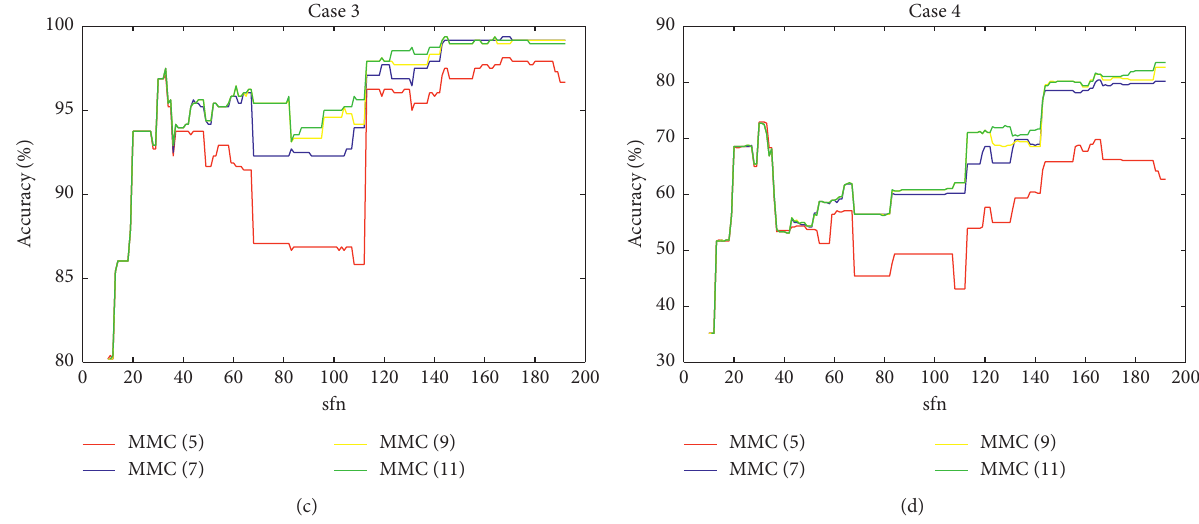
Figure 15: The curve representation of diagnosis results obtained by OFS-TSFRS-MMC-SVM using WPT with different number of dimension sizes for MMC. The MMC (5) represents that the number of dimension size is 5.